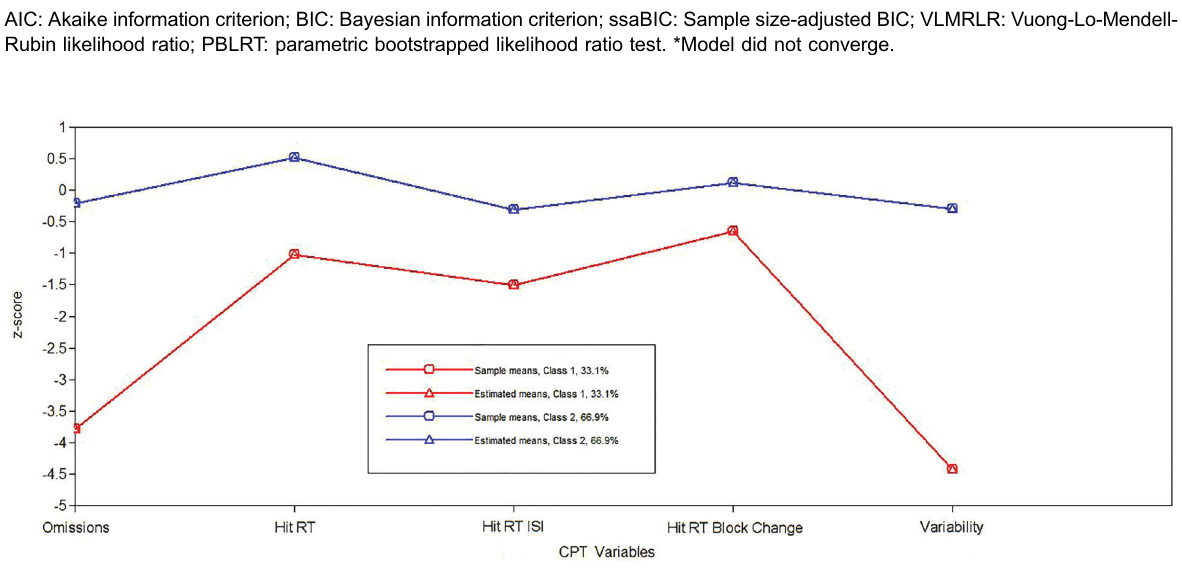
Figure 1. Z-score means for the fi ve Conners ’ Continuous Performance test (CCPT-II) indexes within each latent class for Model 3/ Two-class solution. Child Behavioral Checklist attention problems subscale revealed T-score values of 56.82 for the normal develop- ment class (blue line) and of 72.19 for the ultra-high risk class (red line). Hit RT: Hit Reaction Time; Hit RT ISI: Hit Reaction Time Interstimulus Interval.